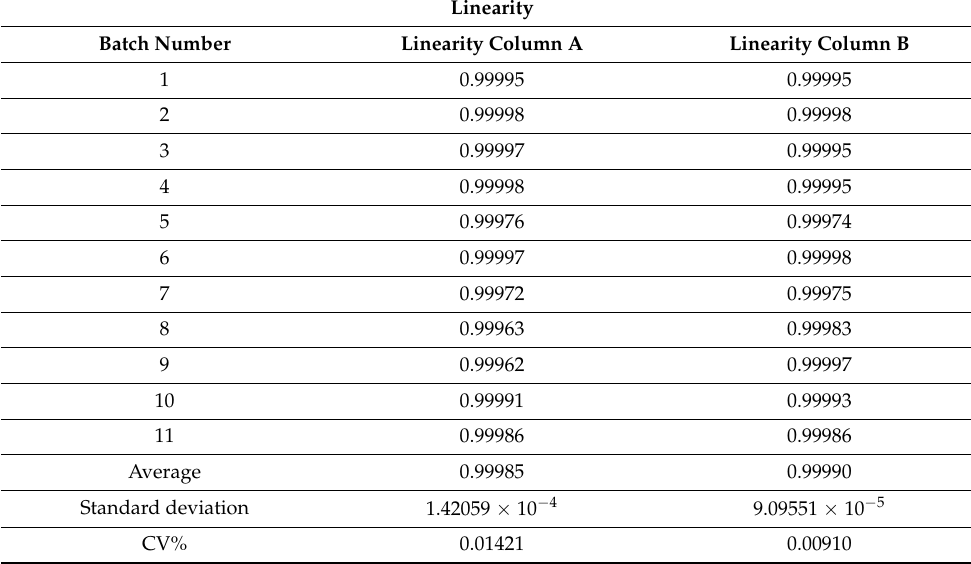
Table 1. Coefficients of determination for dual-column, dual-detector GC-FID analysis of ethanol : The R 2 values on both the BAC 1 (column A) and BAC 2 (column B) columns in all validation batches exceeded the minimum requirement of 0.998 for road traffic toxicology